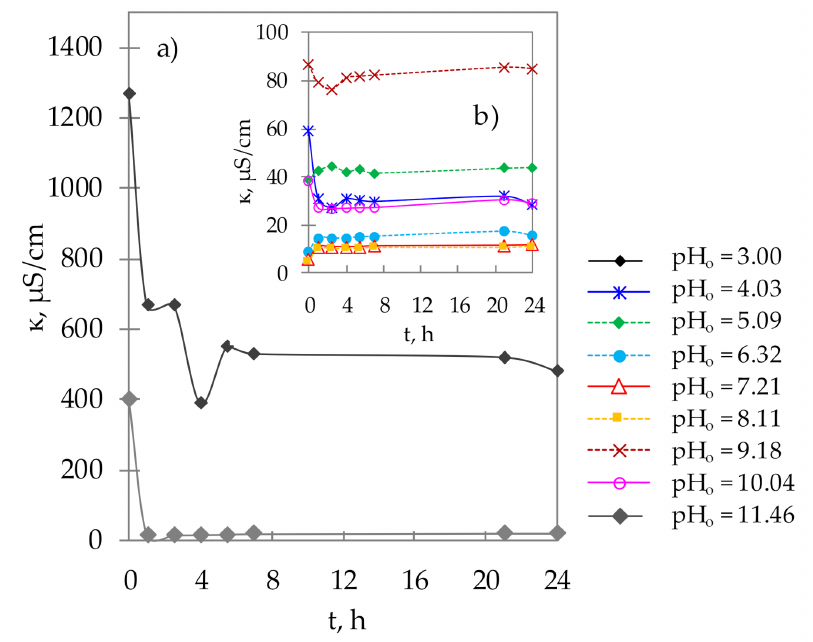
Figure 9. Change in electrical conductivity during the leaching for: ( a ) pH o = 3.00 and pH o = 11.46, and ( b ) pH o =